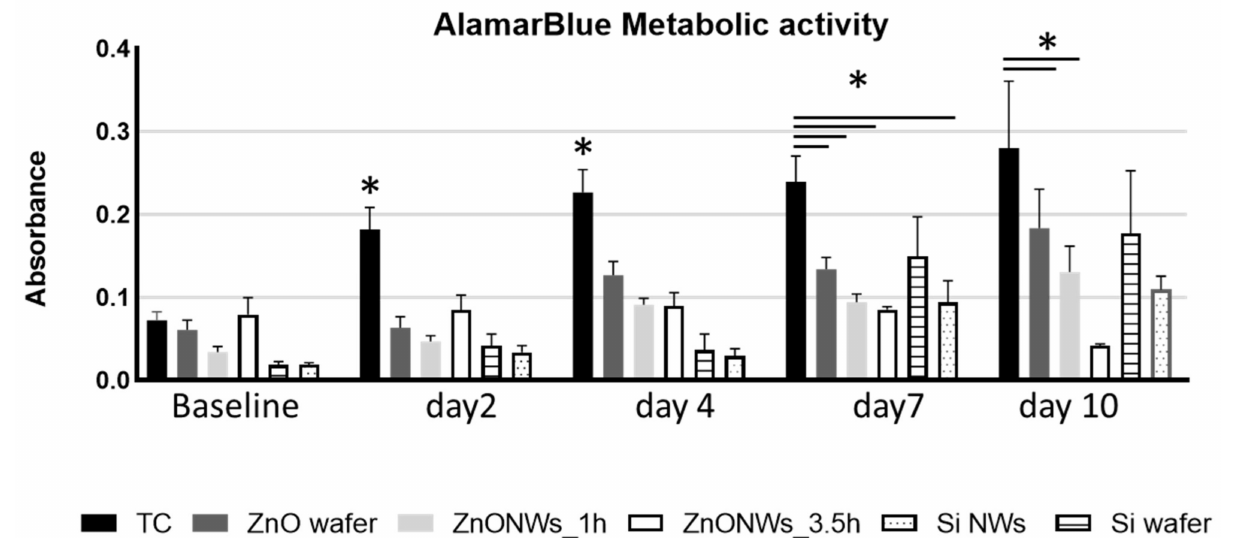
Figure 2. Cardiac stromal cells’ metabolic activity assay cultured in tissue culture plastic (TC), ZnO- and Si-coated wafer, and Si and ZnO nanowires. * p ≤